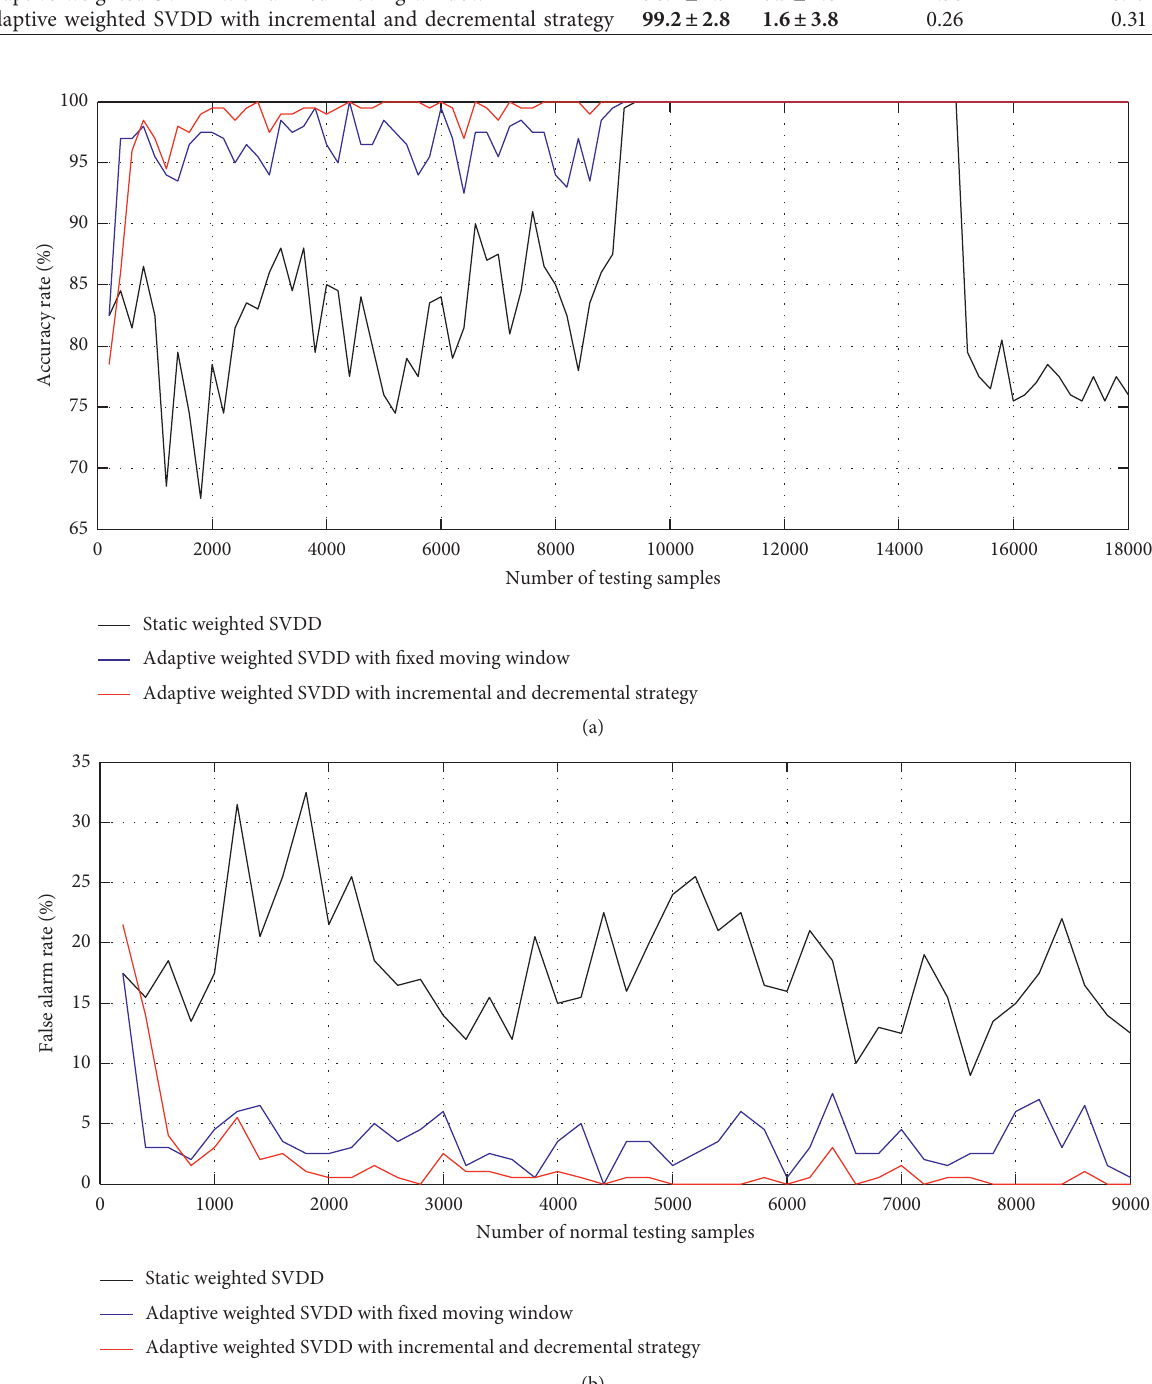
Figure 5: AR and FAR on three weighted SVDD methods. (a) Accuracy rate. (b) False alarm